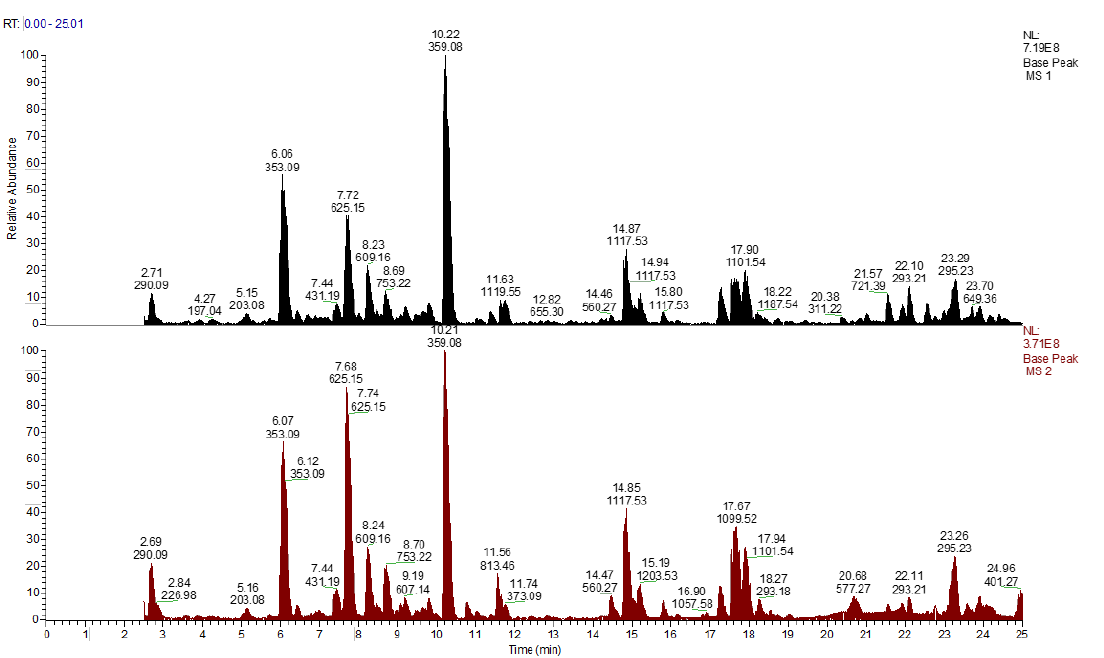
Figure 2. The qualitative analyses of the Eryngium alpinum L. samples from shoots of in vivo plants (black) and in vitro cultures (red). The base peak chromatograms in negative ion mode were obtained using the UPLC-HESI-II-HRMS system.